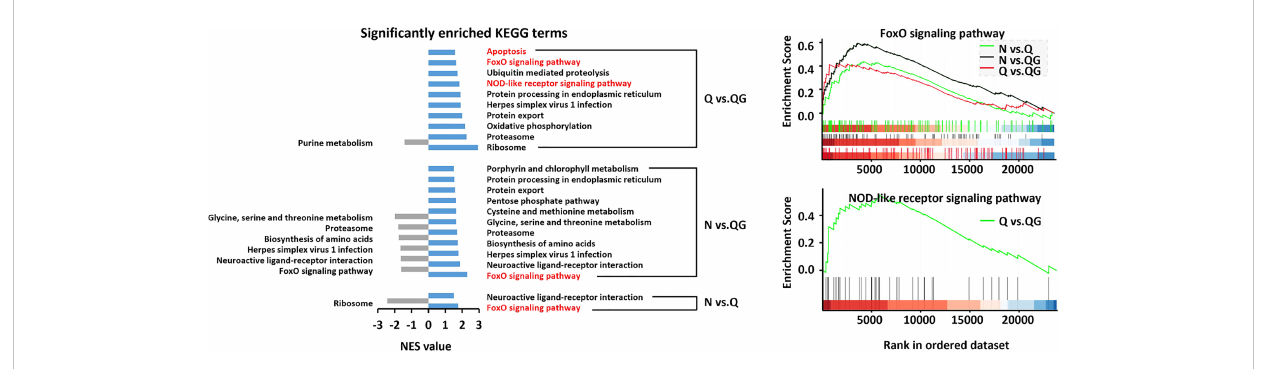
FIGURE 6 The critical KEGG pathways associated with immune response to hypoxia and sul fi de in haemolymph of Tegillarca granosa were explored by gene set enrichment